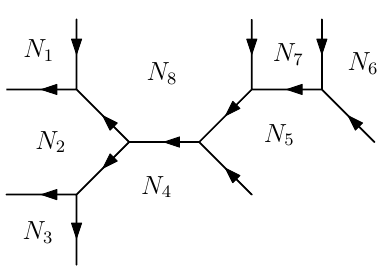
Figure 3. A generic ( p; q )-web with stacks of N i D3 branes attached. The gluing